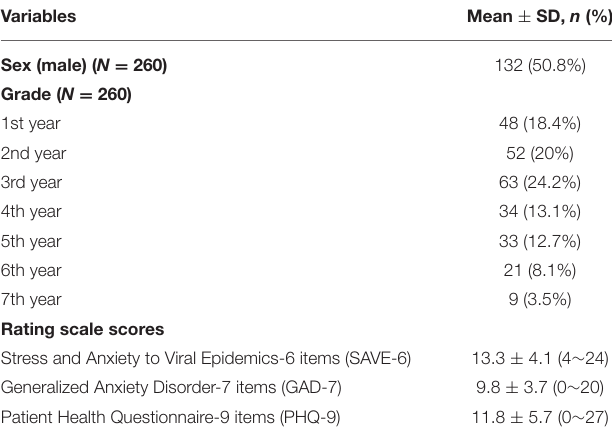
TABLE 1 | Demographic characteristics of